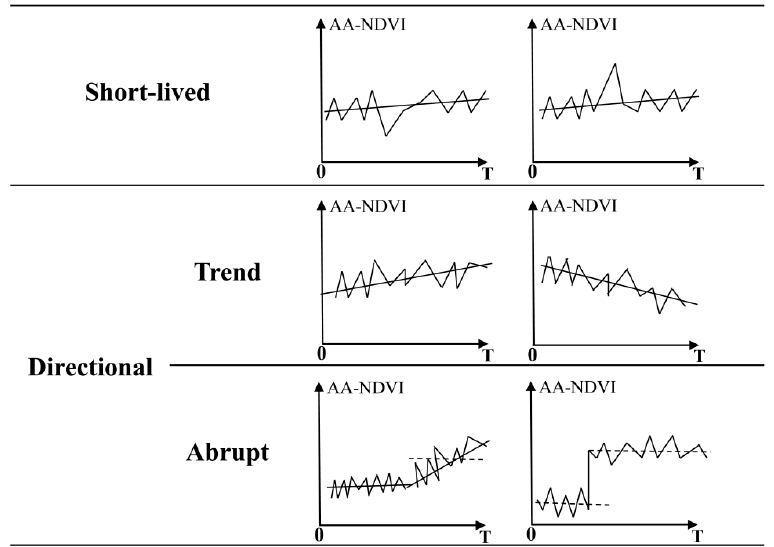
Figure 2. Graphical representations of AA-NDVI trajectories with different change types.